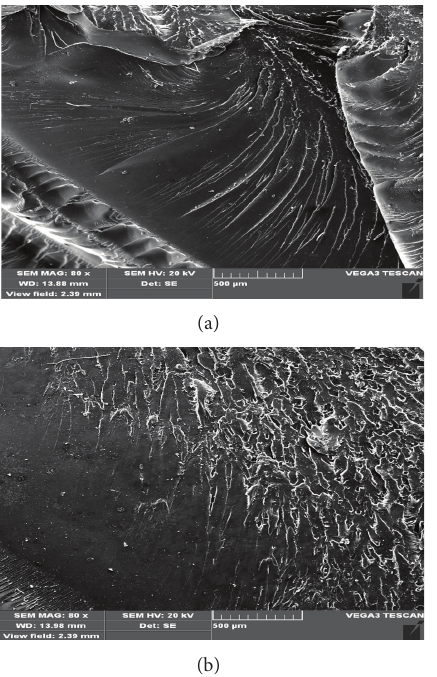
Figure 10: Impact fracture SEM of (a) 1% and (b) 1.5% liquid-like MWNTs/epoxy